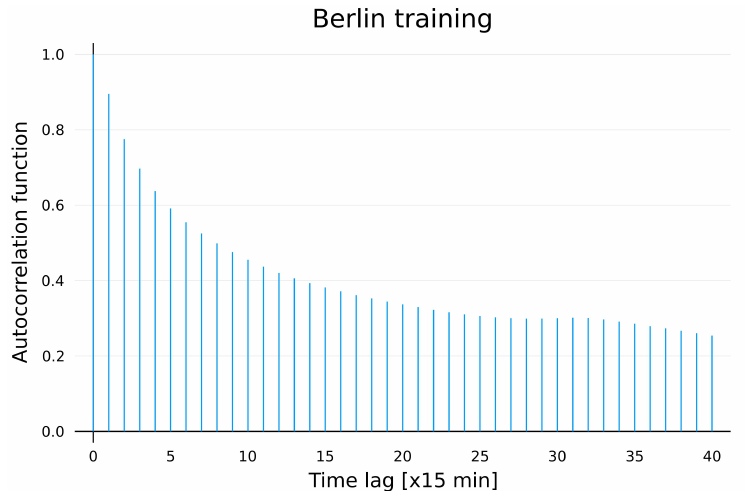
Figure 2. Autocorrelation of CMF with time lags from 0 to 40 time steps for the training set (2004–2018) in